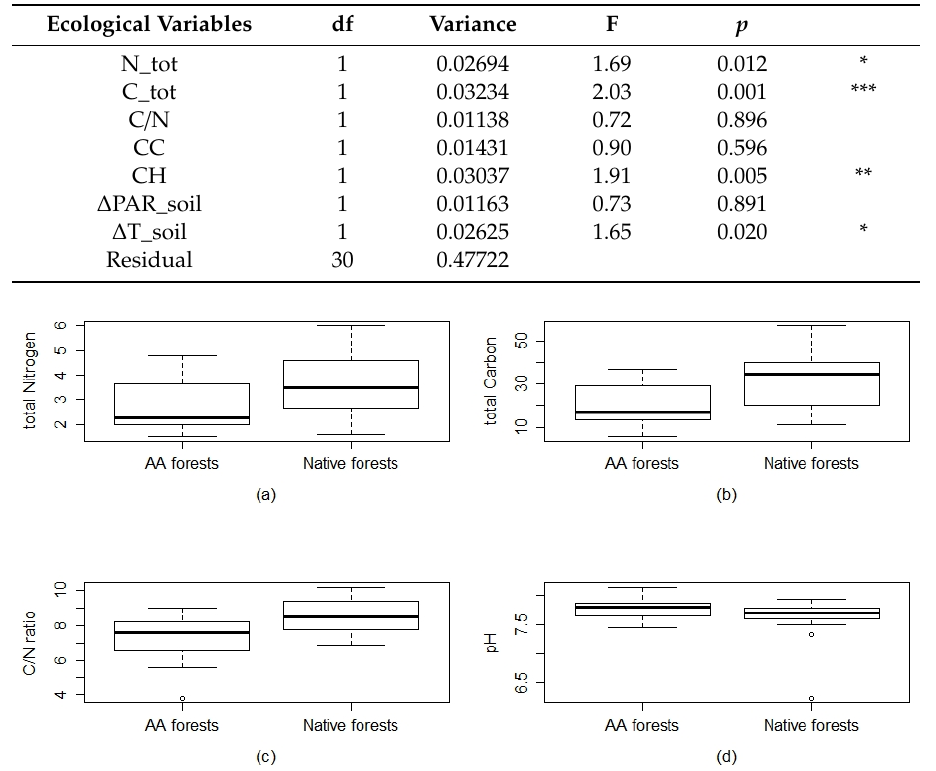
Figure 5. Comparison of the soil chemical parameters measured for the A. altissima and native forests through box plots. ( a ) Total nitrogen, p value = 0.025 * ; ( b ) Total carbon, p value = 0.007 ** ; ( c ) carbon / nitrogen ratio, p value = 0.003 ** ; ( d ) reaction expressed in pH in H2O, p value = 0.1. p level: *** p < 0.001; ** p < 0.01; * p ≤ 0.05. Significant values are in bold.